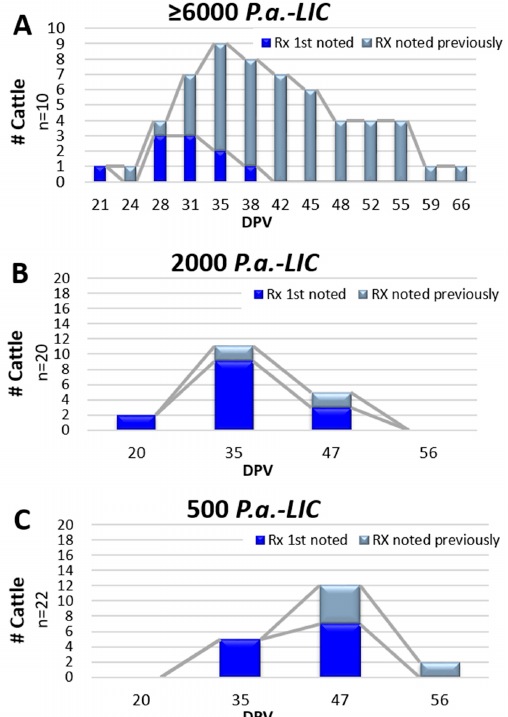
Figure 3. Temporal appearance of injection site reactions (Rx) following inoculation of EBAA vaccine. Vaccine potency varied and is provided at the top of each graph. Data from Graph ( A) was derived from Safety Study #2 while data from Graphs ( B , C) were derived from Efficacy Trial #4. First-time reactions in individual animals are depicted in blue and persisting reactions depicted in gray.